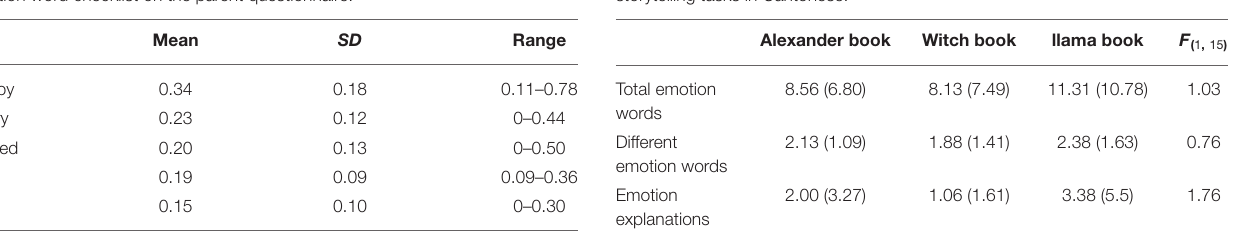
TABLE 5 | Parents’ performance (mean and standard deviations) in the storytelling tasks in Cantonese.